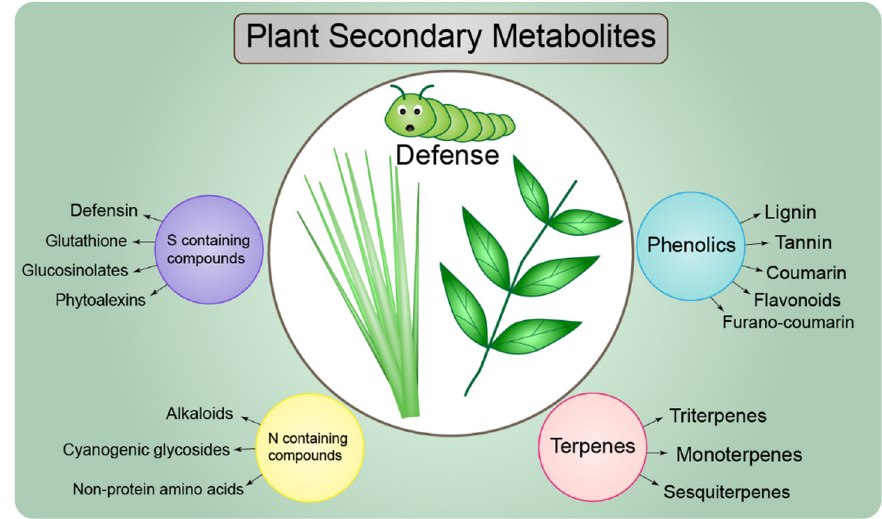
Figure 4. The main plant secondary metabolites (SMs) involved in plant defenses against herbivores, broadly classified as phenolics, terpenes, and sulfur (S)- and nitrogen (N)-containing compounds.